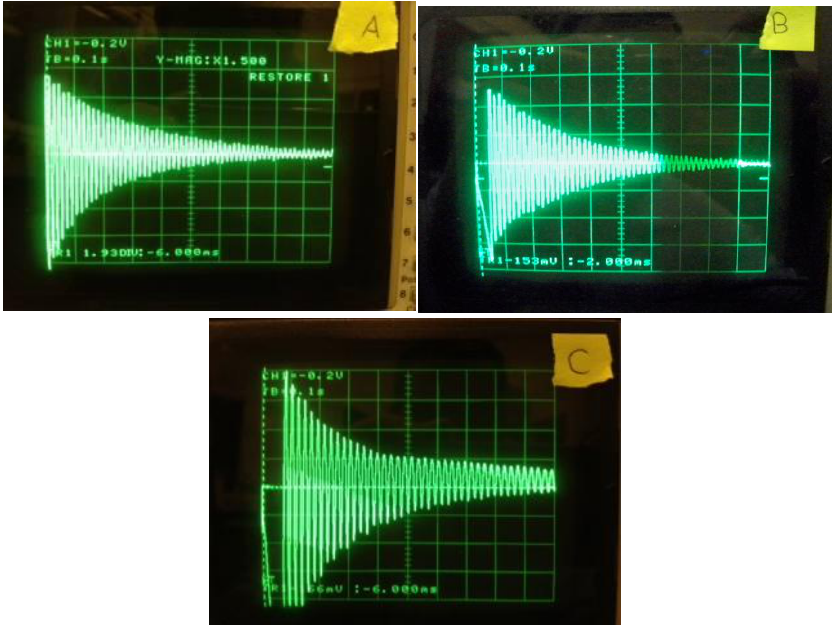
Figure 19. Rate of decay of oscillation measured by the harvester output signal when subjected to free vibration for the three cantilever designs.